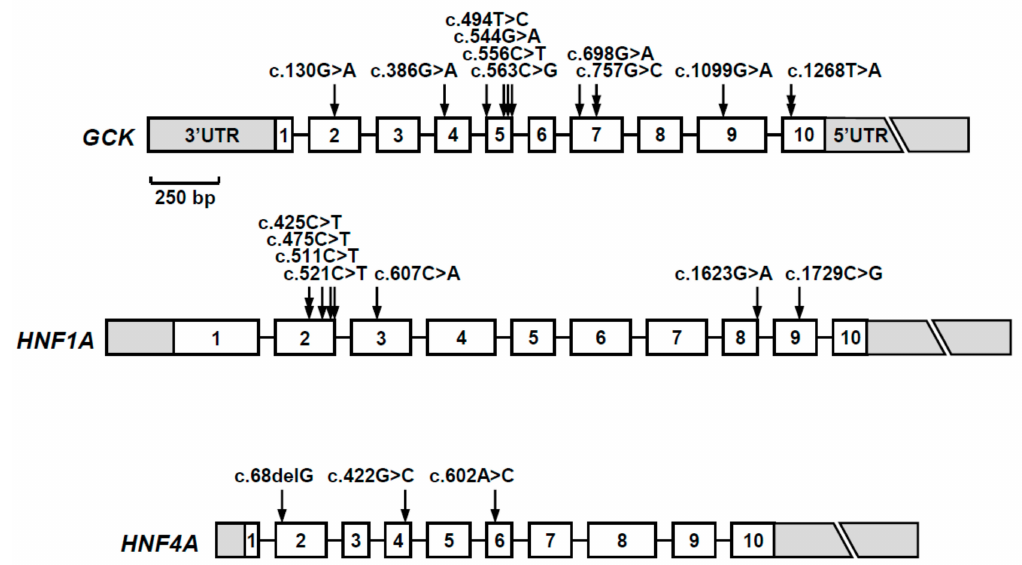
Figure 2. Schematic representation of the GCK , HNF1A, and HNF4A genes and positions of the identified mutations. Numbered boxes represent exons and lines represent introns (not to scale). UTR, untranslated regions. A 250 base-pair (bp) scale is